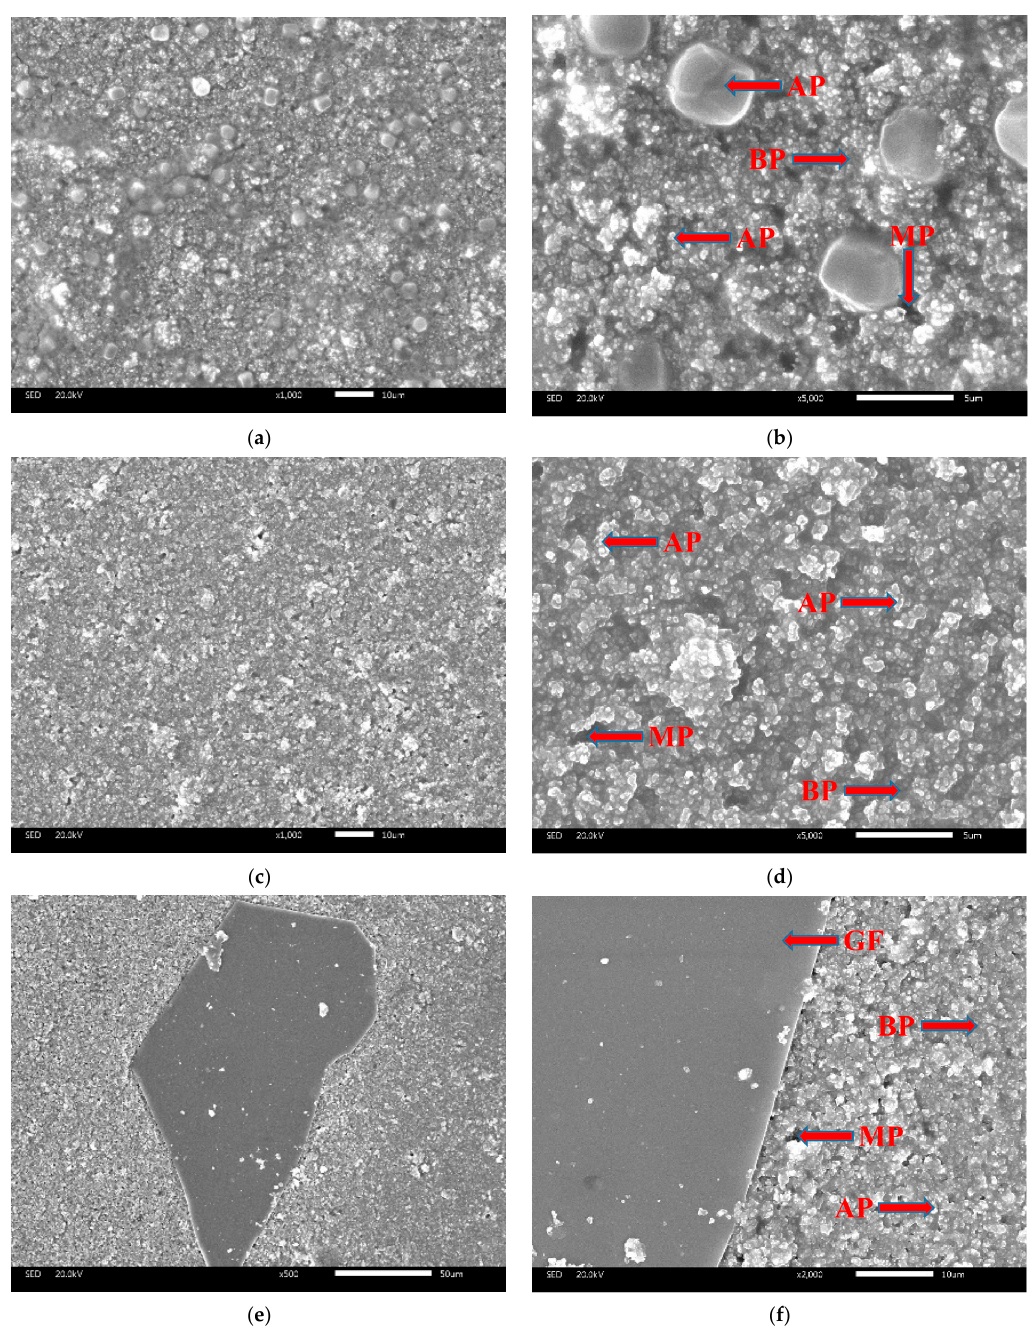
Figure 6. SEM micrographs of coating surfaces (after curing): ( a ) 1000× CBPC; ( b ) 5000× CBPC; ( c ) 1000× GCBPC0; ( d ) 5000× GCBPC0; ( e ) 500× GCBPC10; ( f ) 2000× GCBPC10. Notes: AP (alumina particles), BP (binding phases), MP (micro-porous).